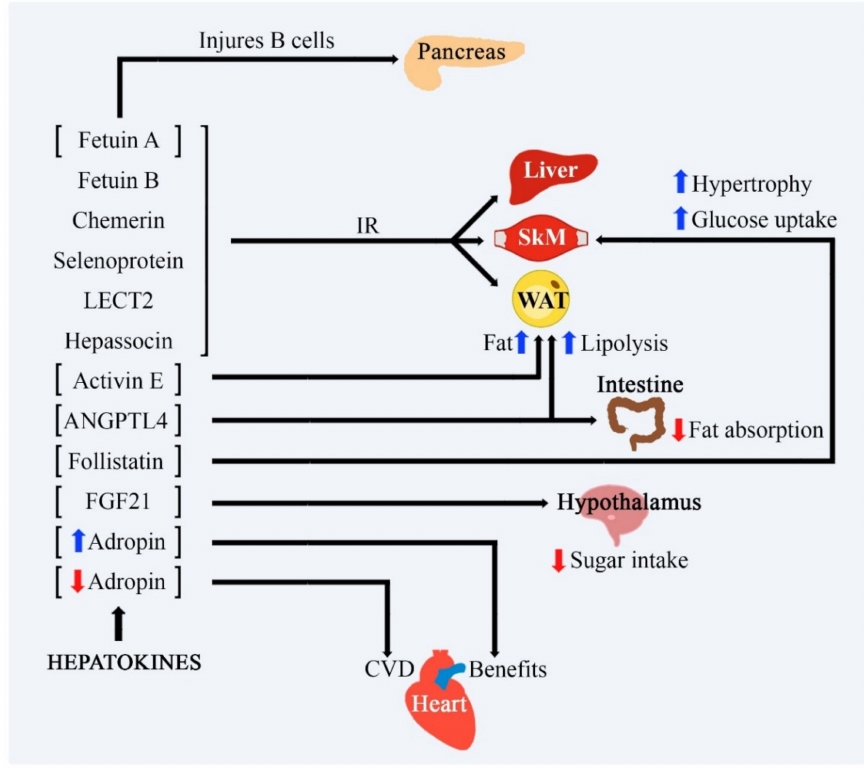
Figure 3. Main functions of hepatokines and their respective activities. [ ↓ ] represents the decrease and [ ↑ ] represents the increase; black arrows represent the release of hepatokines and their actions on each specified target. FGF-21: fibroblast growth factor-21; ANGPTL4: Angiopoietin-Like 4; LECT2: Leukocyte cell-derived chemotaxin 2; SkM: Skeletal Muscle; WAT: white adipose tissue; CVD: Cardiovascular disease e IR: Insulin